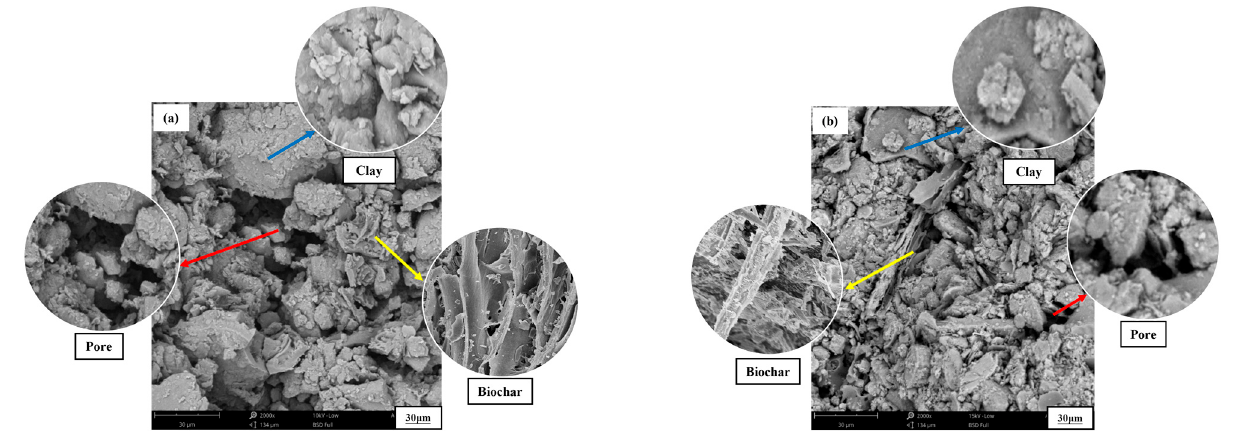
Figure 16. SEM images of the biochar–clay mixture under different biochar contents: ( a ) α = 10%; ( b ) α = 15%.